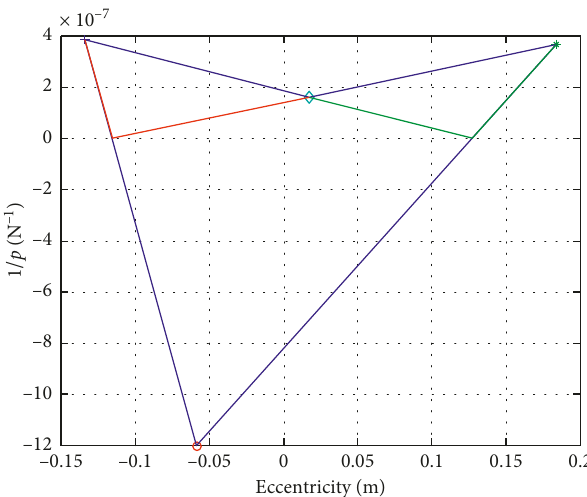
Figure 4: Magnel design diagram in the supporting ends.